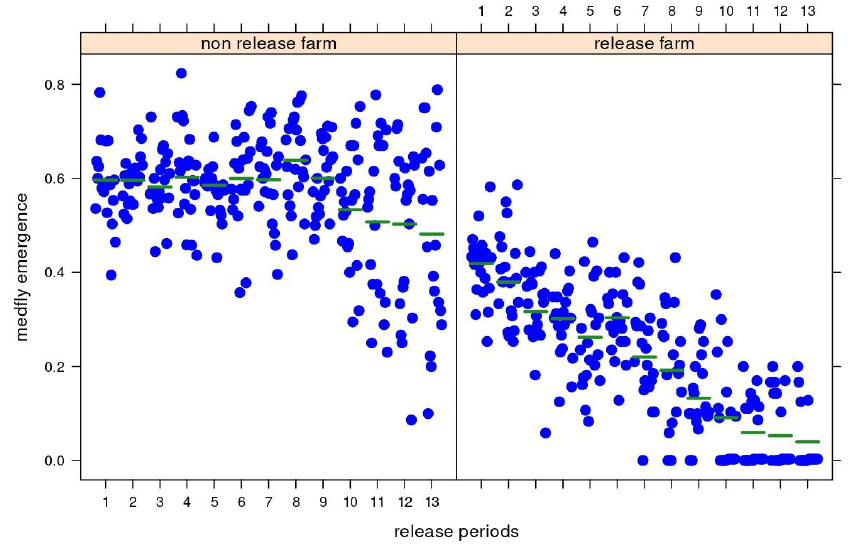
Figure 4. Direct influences of treatment (non-parasitoid release farm (CF) and parasitoid ( Diachasmimorpha longicaudata ) release farm (TF)) and release period (1 to 13 from summer to autumn) on medfly emergence (proportion of emerged medfly adults) on two experimental fruit farms in San Juan, central–western Argentina. The fitted green central line depicts the partial regression from the GLS model applied to individual data by period, while the blue points are the observed ones. The partial residuals show that the magnitude of medfly emergence decreases throughout periods within seasons, and the decreasing trend in medfly emergence is higher on the parasitoid release farm.